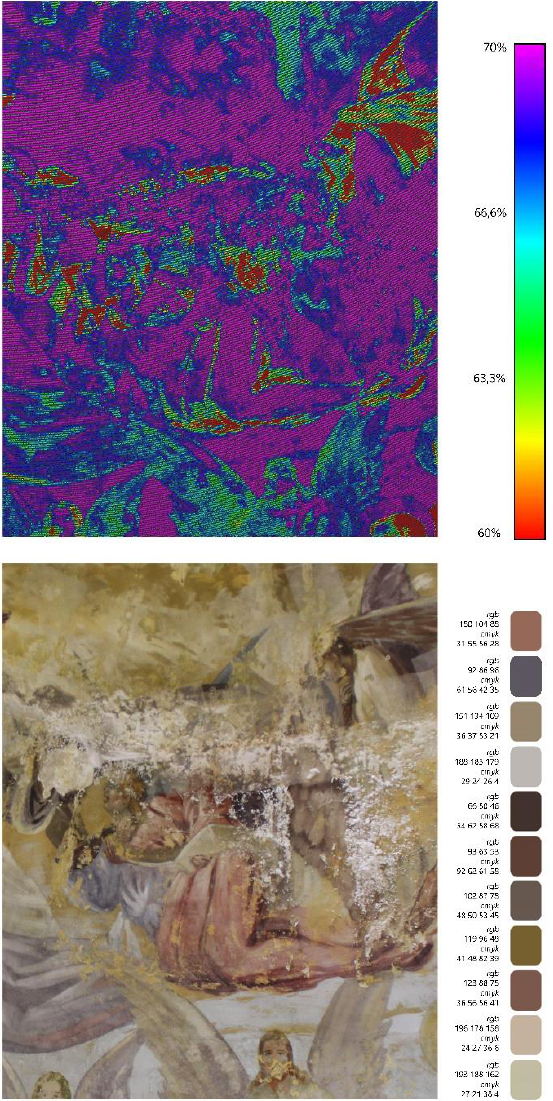
Figure 6 . Reflectance map and colour classification for a detailed portion of the damaged fresco. The variations highlight portions with inhomogeneous and inconsistent